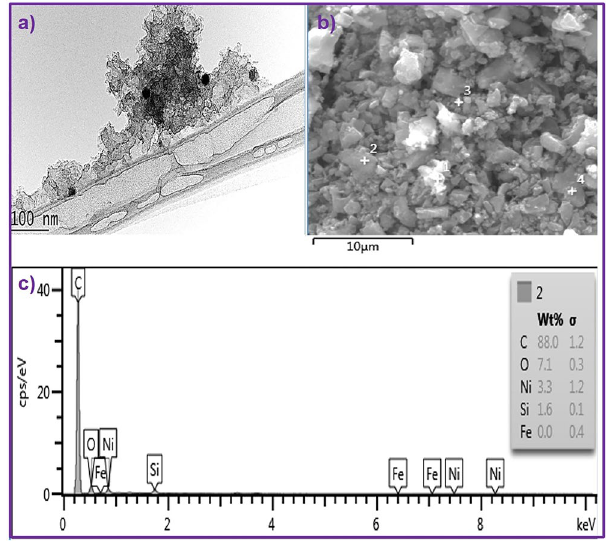
Figure 1. ( a ) TEM image and ( b ) SEM image of Ni doped PAC and ( c ) EDX profile of the selected area of ( b